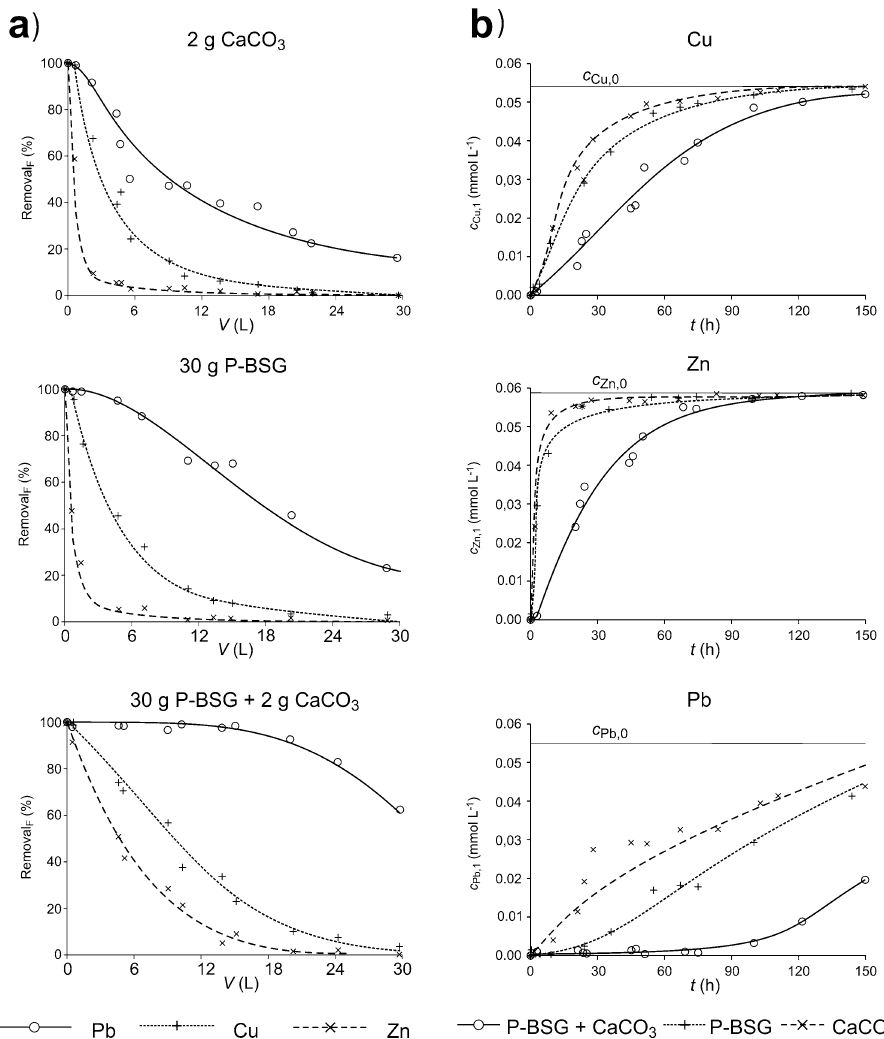
Figure 8. Comparison of the removal efficiency of Cu 2+ , Zn 2+ and Pb 2+ cations from the multi-component solution in the column filled with P-BSG, P-BSG with CaCO 3 addition and with inert filling with addition of CaCO 3 . The standard deviation from the mean value determined for Cu did not exceed 10%, and 14% for Zn and Pb,